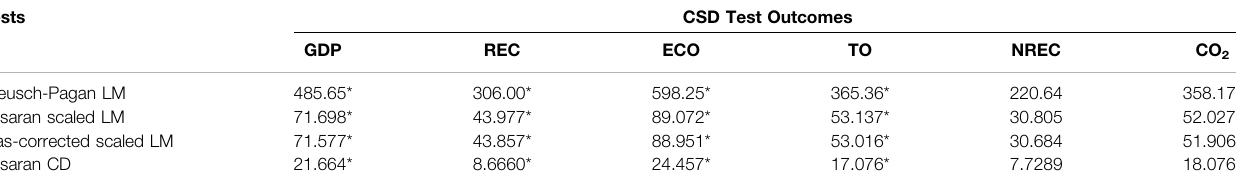
TABLE 3 | CSD and CIPS Tests Outcomes.